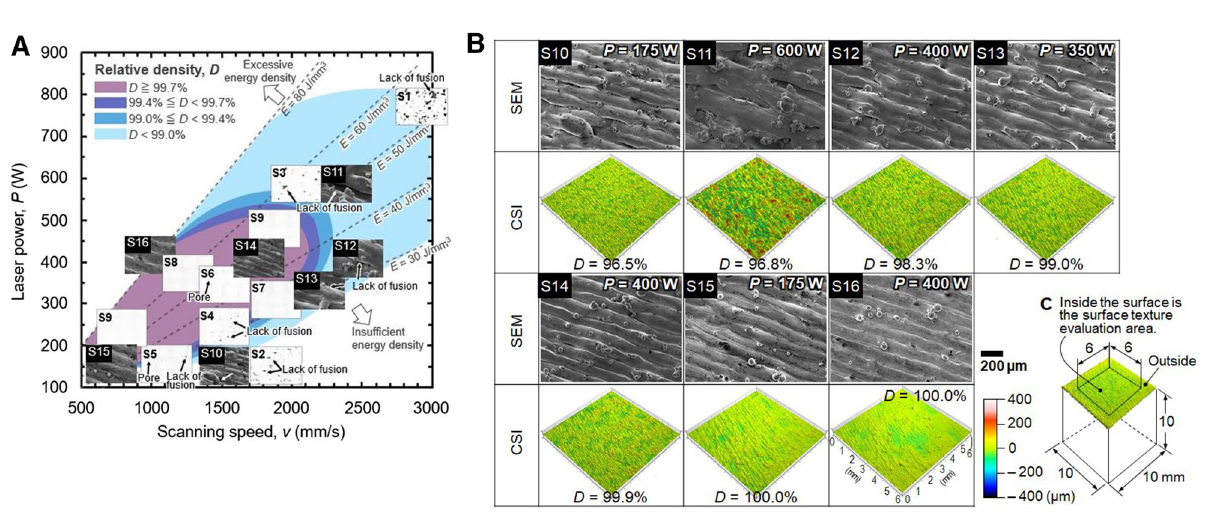
Figure 4. Relationship between surface texture and internal defects—( A ) relative-density-based process map between laser power and scan speed, including surface-texture and internal-defect images; ( B ) SEM and CSI images of cubic specimen (S10–S16) surface; ( c ) surface-texture evaluation area. Images created using Microsoft Office Excel 2019 (https:// www. micro soft. com/ ja- jp/ micro soft- 365/ excel), PC-SEM Ver.5.1.0.11 (https:// www. jeol. co. jp/), Mx Ver.7.3.0.5 (https:// www. zygo. com/ produ cts/ metro logy- syste ms/ metro logy- softw are/ mx- for- 3d- optic al- profi lers) and TalyMap Plutinum Ver.6.2.7029 (https:// www. taylor- hobson. Relationship between surface texture and internal defects. The schematic process map corre- sponding to Fig. 1B superimposed with the surface-texture and internal-defect of specimens S1–S16 is depicted in Fig. 4A. Reference to these figures reveals that for the high-density specimens S15 and S16, the width of the tracks (melt-pool traces) remains relatively constant, and no grooves can be observed between these tracks. As noted earlier, negligible pores exist in full-density specimens. In contrast, the said track width in low-density specimens S10, S12, and S13 remains irregular, and the surface contains several bumps and grooves. Thus, wider grooves are observed at lower laser powers, and an increase in laser power increases the width and unevenness of the tracks. Further, despite a density similar to that of S10, the surface of specimen S11 fabricated using the highest laser power (600 W) is characterized by wider tracks and grooves and greater track unevenness. This can be attributed to the large swelling (“beading-up”) of the melt pool caused by the Rayleigh–Plateau capillary insta- bility at the high energy density 45 . Consequently, lack-of-fusion defects and pores appear in these specimens.